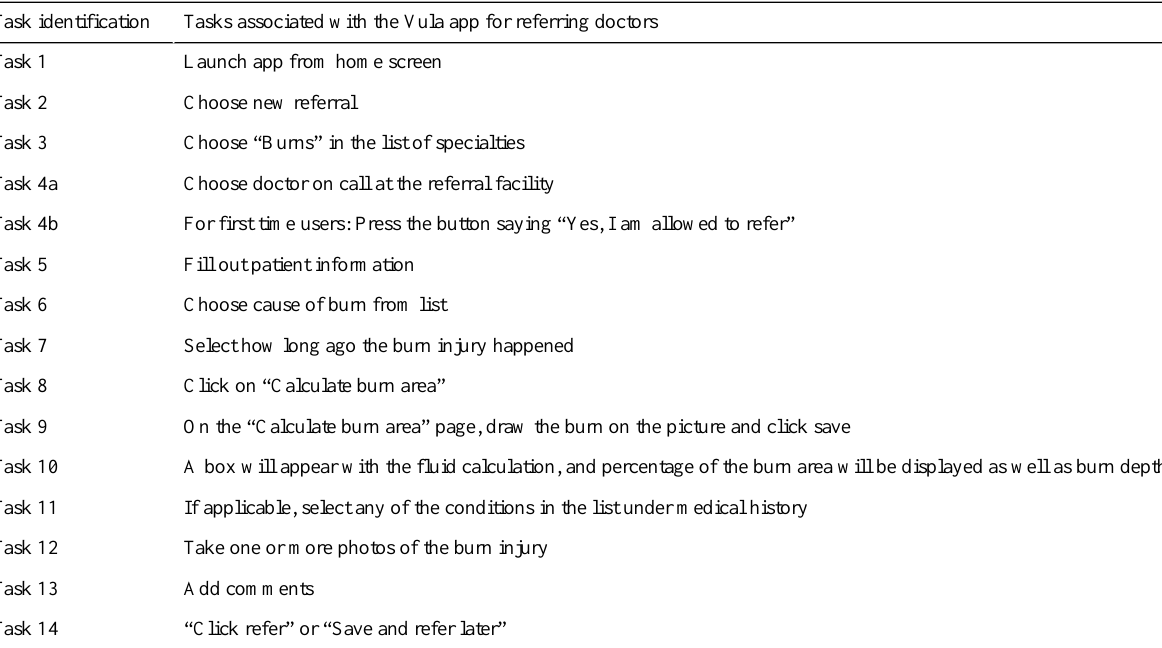
Table 1. Tasks associated with the Vula app for referral